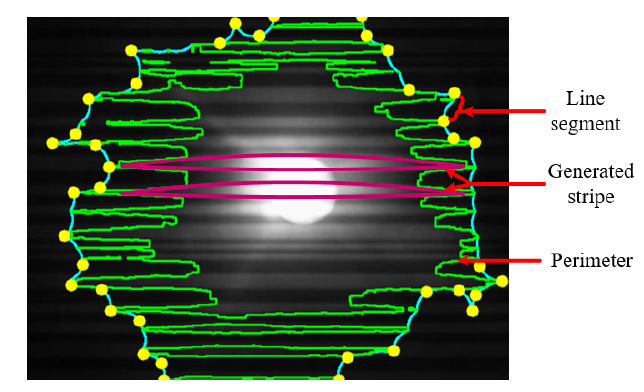
Figure 6. Example of a single LED image frame where all the generated stripes are combined together and a contour is formed.